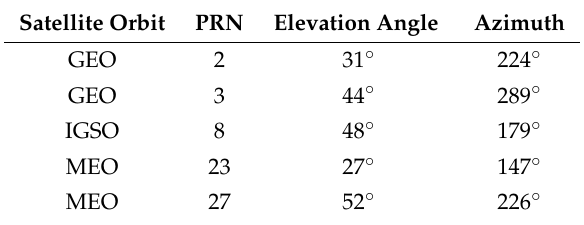
Figure 15. Satellite status information of the BeiDou satellite during data collection. Table 4. Status information of five acquired BeiDou satellites in the second experiment.